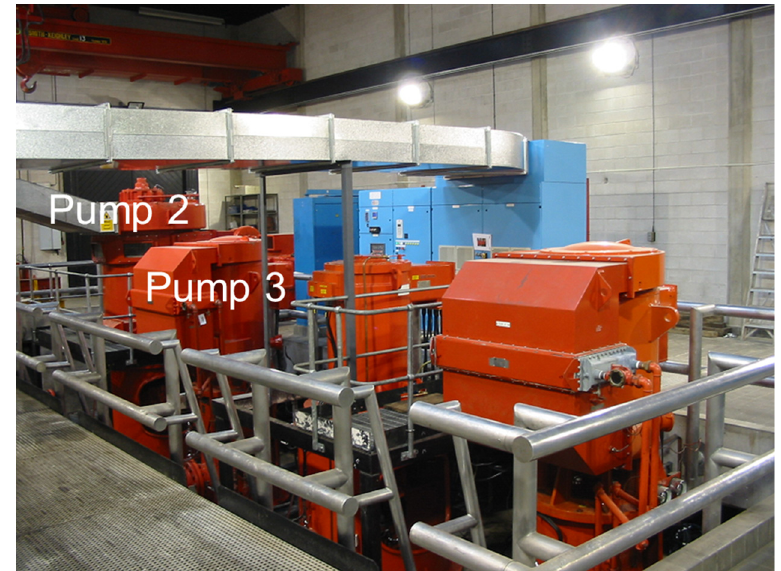
Figure 12. Arrangement of pumps inside pumping house, showing pump 2 (left), pump 3 (middle), and pump 1 (right). Pipework is housed out of view under the metallic walkway.